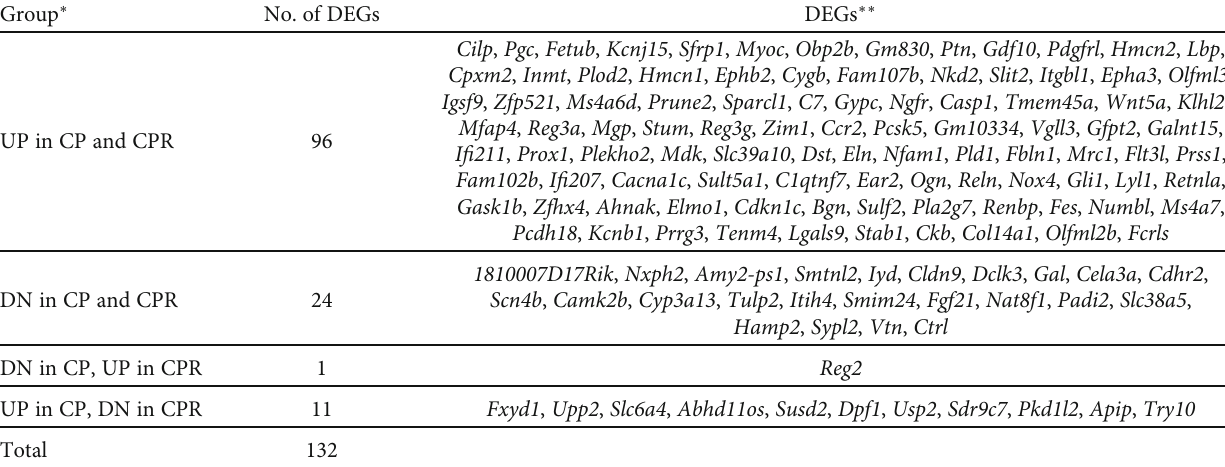
Table 1: DEGs shared between CP and CPR.